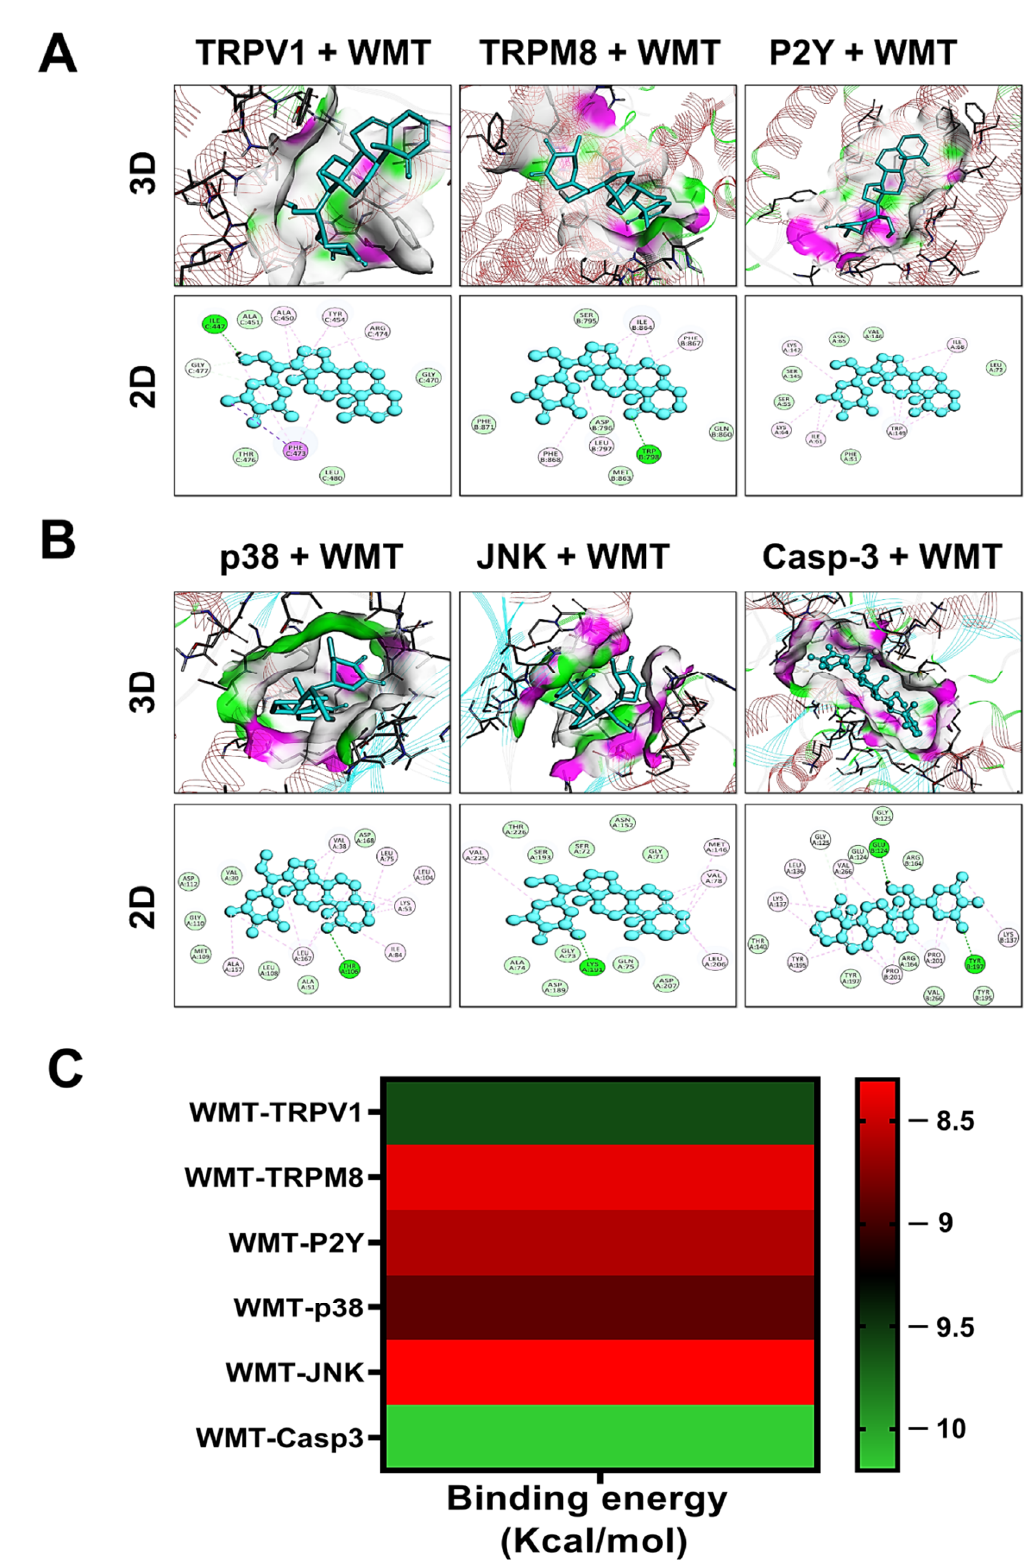
Figure 15. Docking analysis of withametelin with TRPV1, TRPM8, P2Y ( A ), p38, JNK, and caspase-3 ( B ). The two-dimensional (2D) and three dimensional (3D) structural interactions between the ligand and protein macromolecules are shown. Withametelin docked well in the active site of the protein targets. The heat map showed the binding energy of the protein targets ( C ). Withametelin exhibited a higher binding affinity with the protein targets and had multi-target binding